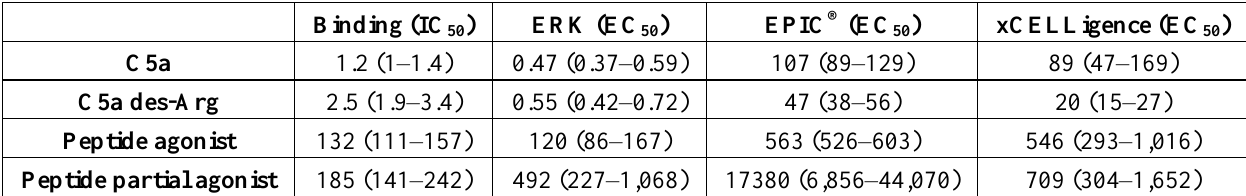
Table 1. Potency of ligands (nM) on HMDM across the different platforms tested. Binding assay performed using 25 pM 125 I-C5a. EC intervals (n = 3 − 8).